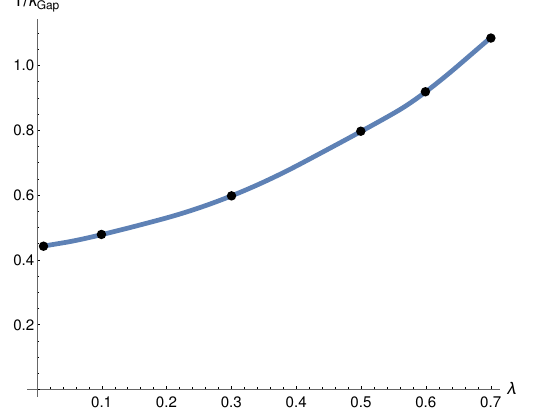
Figure 4 . The Debye and quantum critical damping coe(cid:14)cients entering in expression (3.6) in function of the electromagnetic coupling (cid:21) . The plot emphasize the very di(cid:11)erent nature of the two relaxation scales.